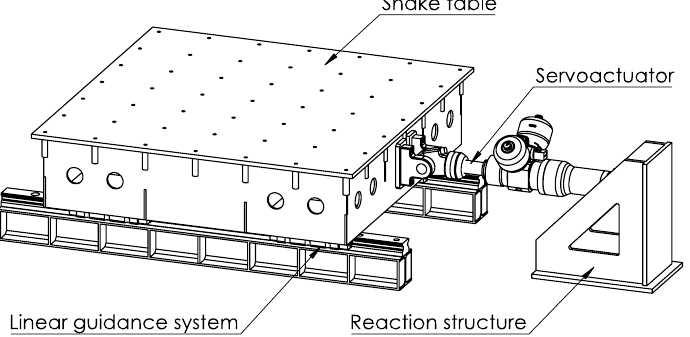
Figure 3. Shake table system. Courtesy of Vzero Engineering Solutions, SL.